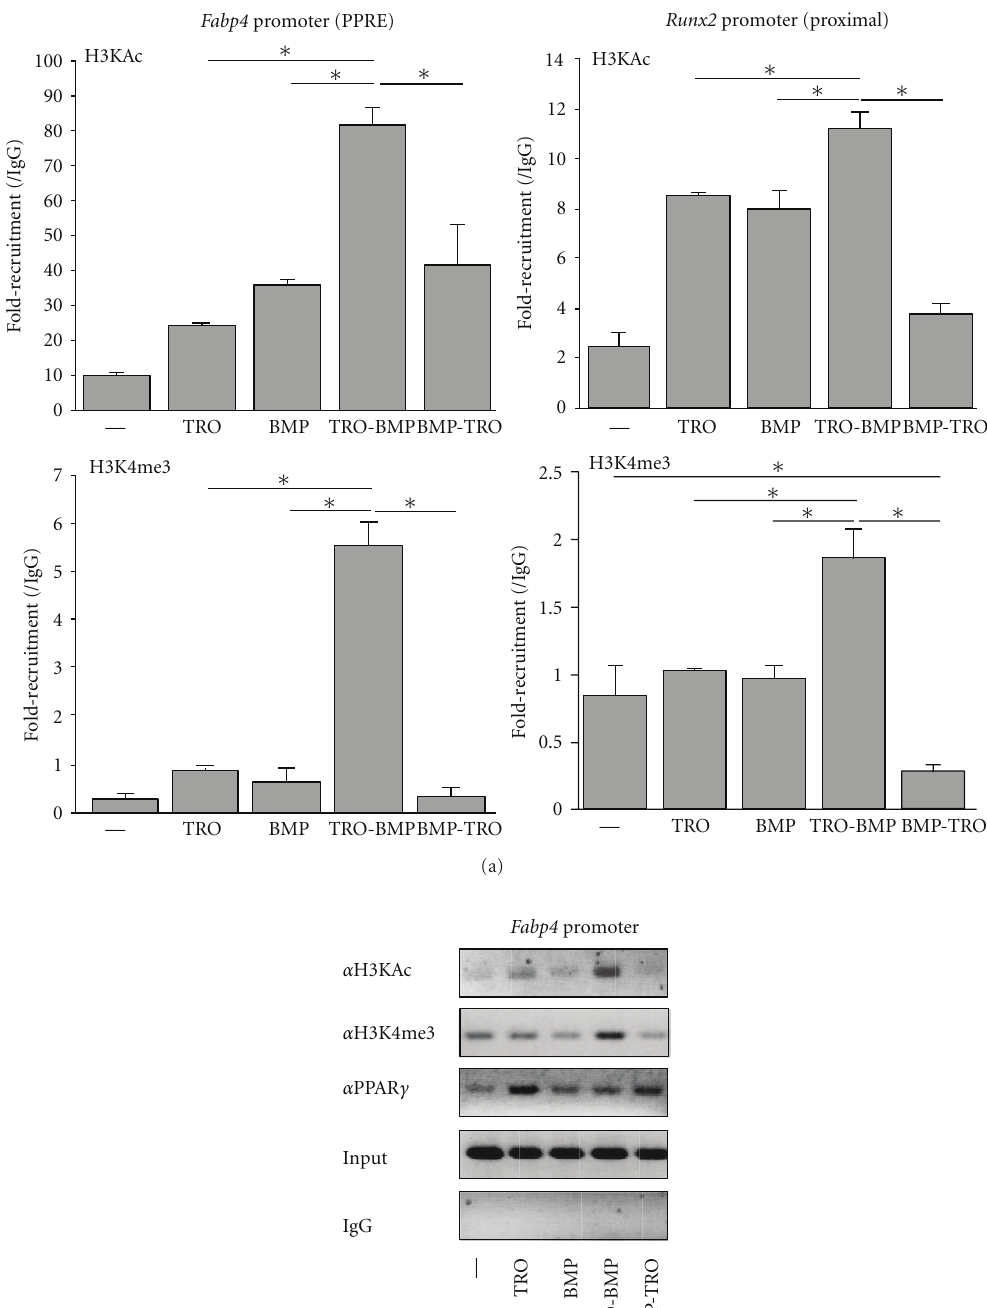
Figure 3: ChIP analysis of ST2 cells treated with/without BMP2 and/or TRO. (a) After ST2 cells were cultured under the conditions described in Figure 2, cells were lysed and ChIP analysis was performed according to the manufacturer’s protocol (Millipore) using the indicated antibodies. H3KAc, anti-acetylated Lys histone H3 (Millipore); H3K4me3, anti-trimethylated Lys4 histone H3 (Millipore). Samples were examined by qPCR using CFX96 (Bio-Rad). Primers were used as previously reported [19]. Each experiment was performed at least three times. Student’s t -tests were performed. ∗ P < 0 . 05. (b) ChIP analysis of ST2 cells using anti-H3AcK, -H3K4me3, and -PPAR γ . ChIP assays were performed under the same conditions as (a). PCR was performed as described and visualized on 2% agarose TAE